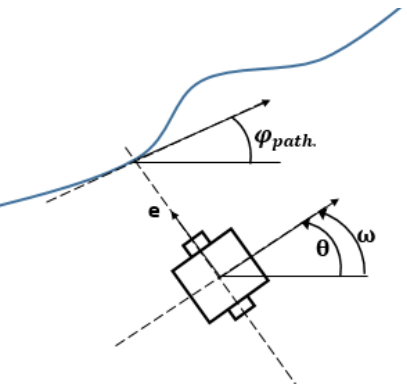
Figure 2. Schematic representation of the lateral control proposal.